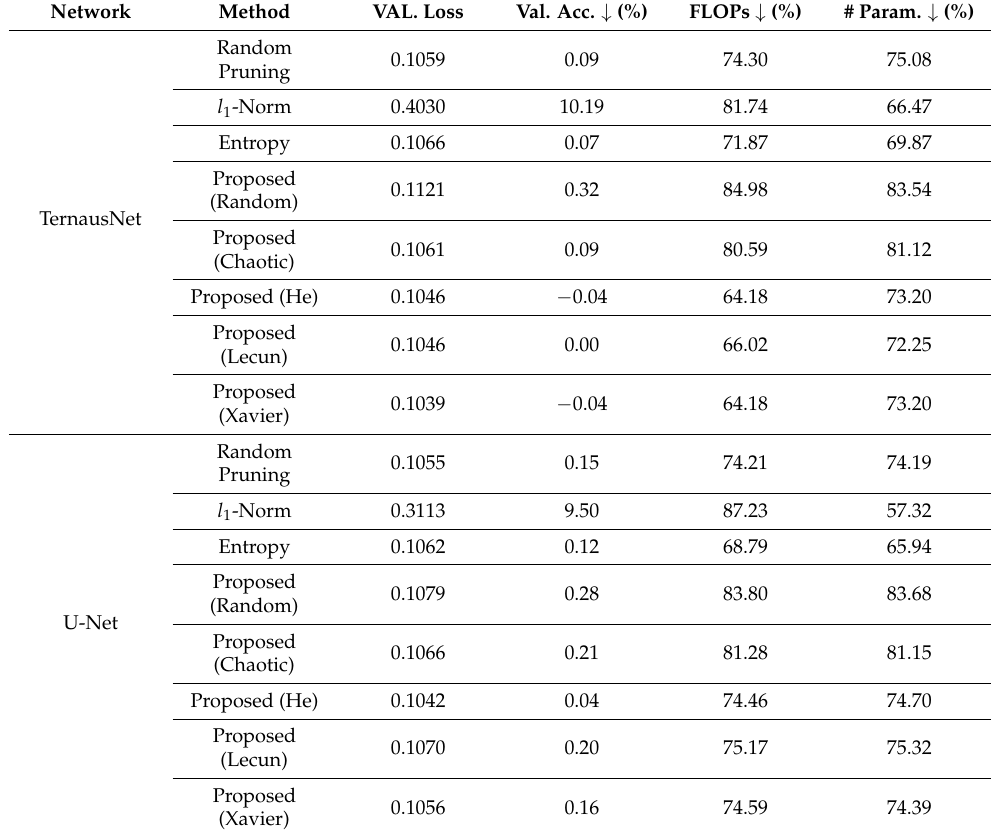
Table 2. Comparison with the state-of-the-art methods for pruning TernausNet and U-Net on Inria dataset. “# Param.” indicates number of parameters, and “ ↓ ” represents the reduction